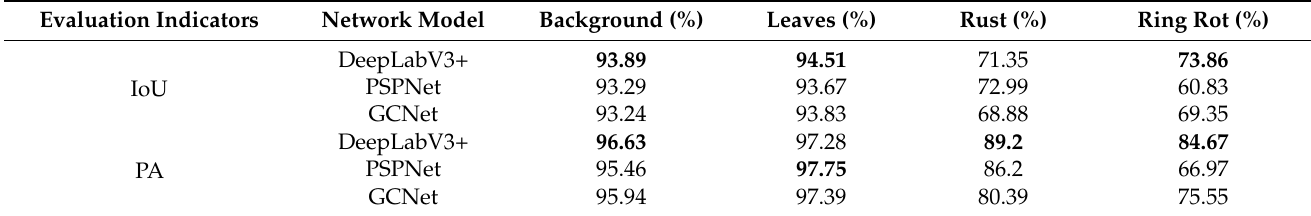
Table 3. PA and IoU indicators of different models.